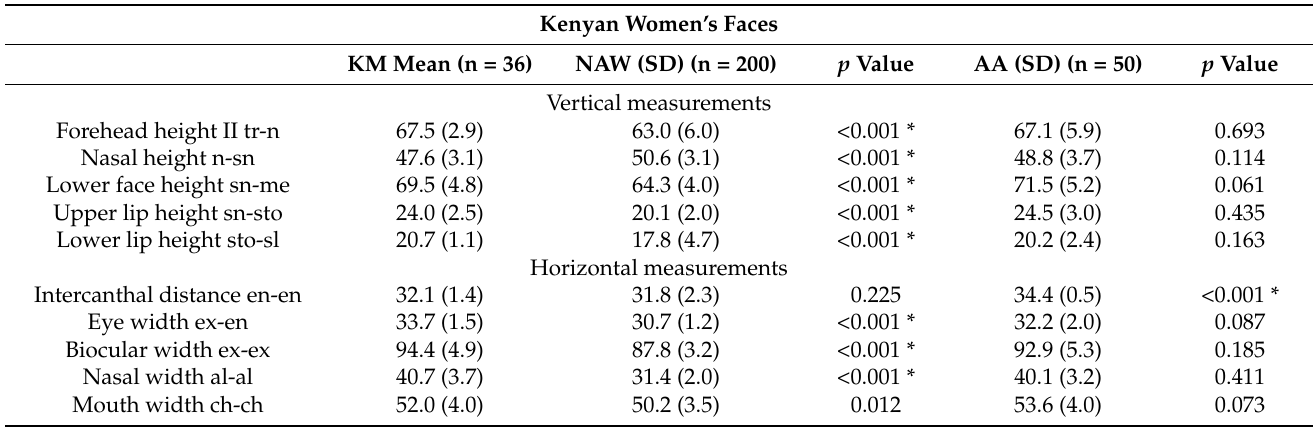
Table 16. Facial anthropometrics comparison of Kenyan Females with African Americans and North American